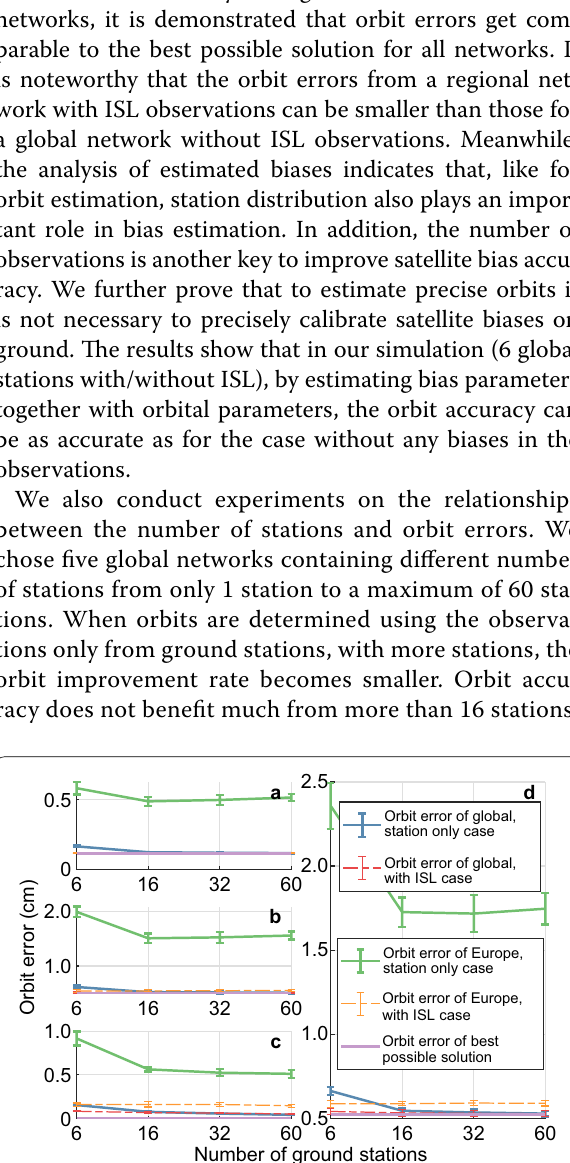
Fig. 8 Mean RMS of orbit errors with respect to the number of ground stations for 2 regions in a radial, b along-track, c cross-track directions and d 3D position. Note in different